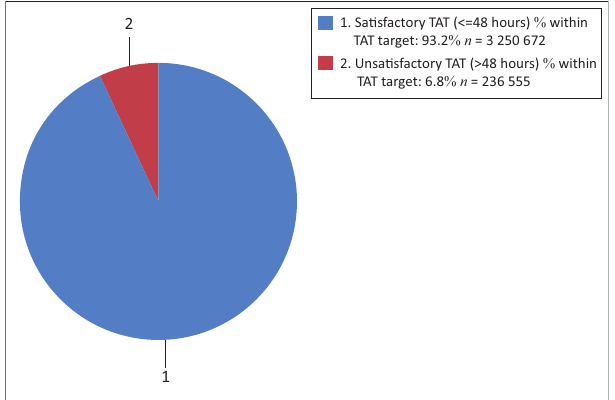
FIGURE 3: A pie graph representing sample volumes and percentage of samples with satisfactory (≤ 48 h) and unsatisfactory (> 48 h) CD4 turn-around time performance in the 2015–2016 fiscal period overall.